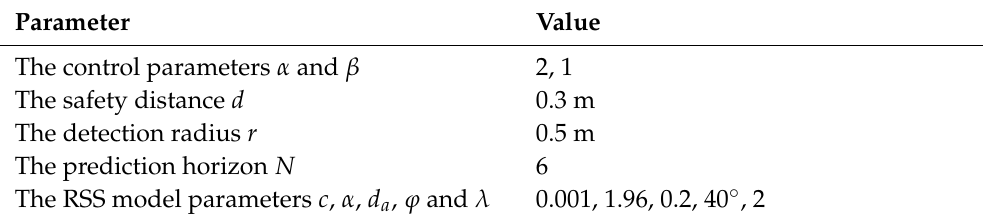
Table 1. The simulation parameters.